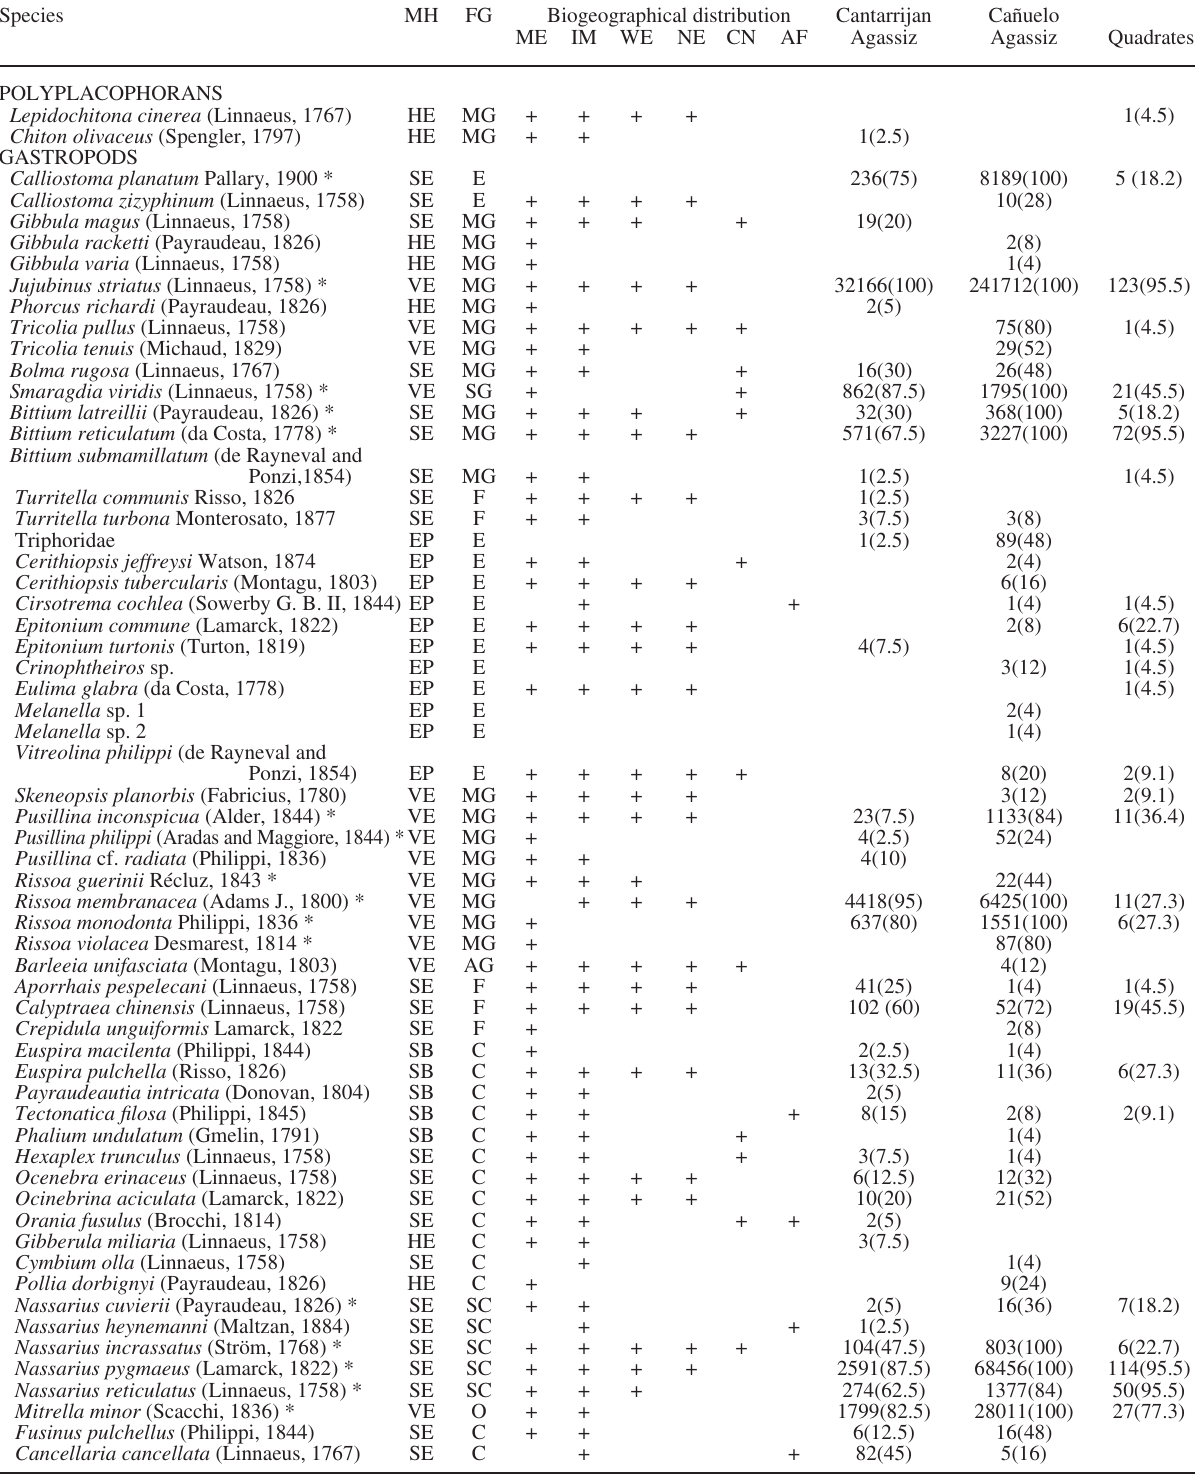
Table 2. – faunistic list of molluscs found in Zostera marina beds in southern spain, with quantitative data from arroyo et al. (2006) (Cantar- riján, agassiz), Rueda et al. (2008b) (Cañuelo, agassiz) and Rueda and salas (2008) (Cañuelo, quadrates). Codes for preferred micro-habitat within the eelgrass bed (mH), feeding guild (fg) and biogeographical distribution as listed in Table 1. Total number of individuals collected (n ind) and values of frequency index (among brackets) are also indicated for each species in each of the surveys. dominance index for each species can be calculated as percentage of n ind in relation to total number of molluscs collected in each survey. species marked with * are illustrated in figures 2 to 7. un: